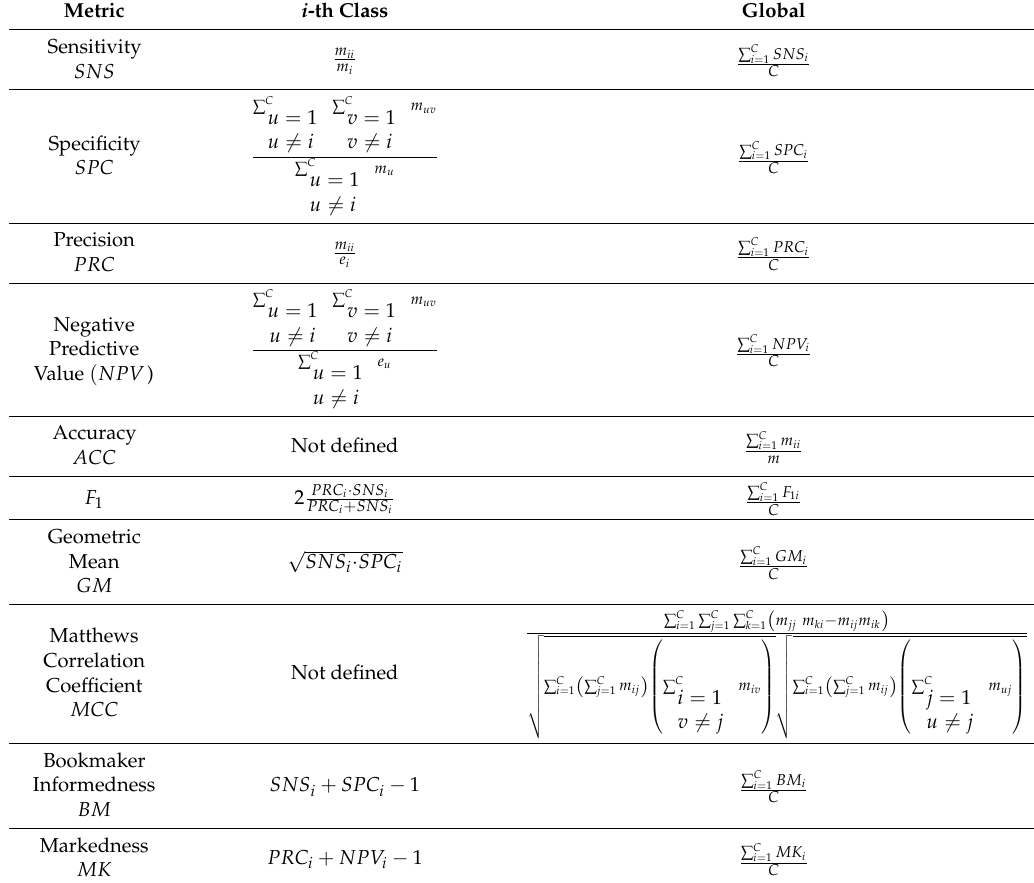
Table 3. Classification performance